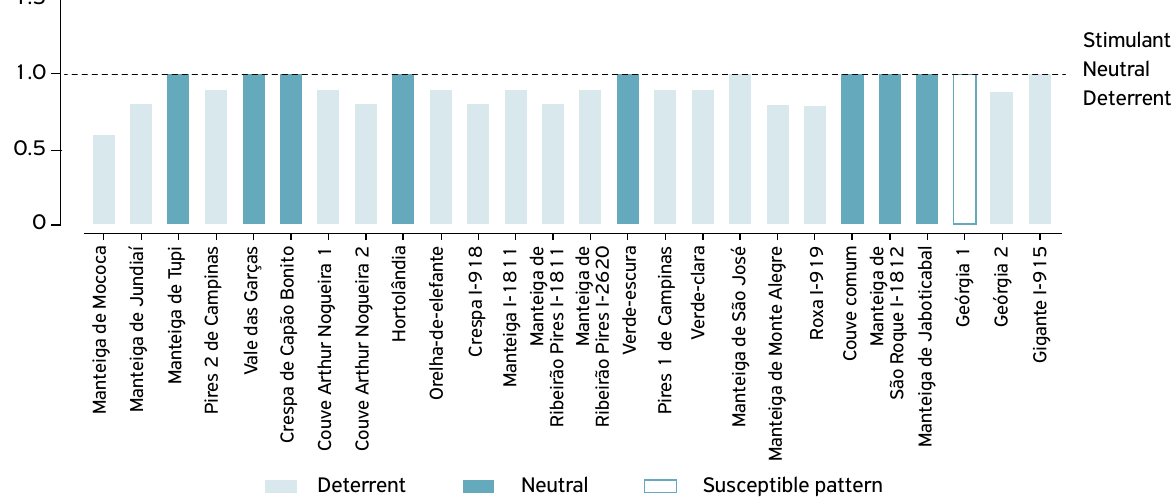
Deterrent Neutral Susceptible pattern Figure 1. Attractiveness index of Ascia monuste orseis (Lepidoptera: Pieridae) in collard greens genotypes in free-choice test (temperature 25 ± 2ºC, relative humidity 70 ± 10% and photoperiod 12:12 light/darkness).